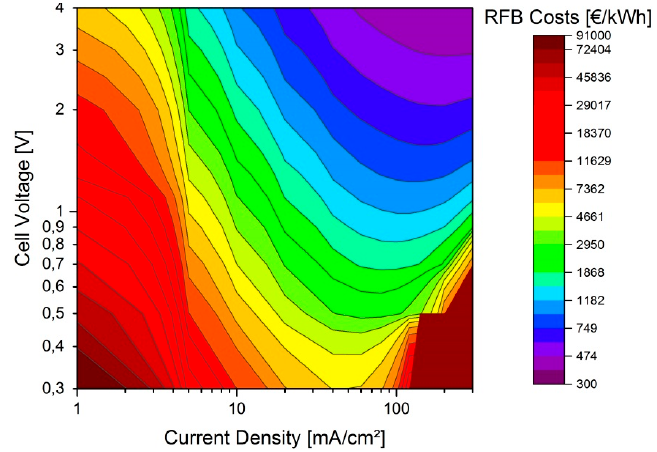
Figure 8. Influence of cell voltage and current density on the system costs of redox flow battery systems.